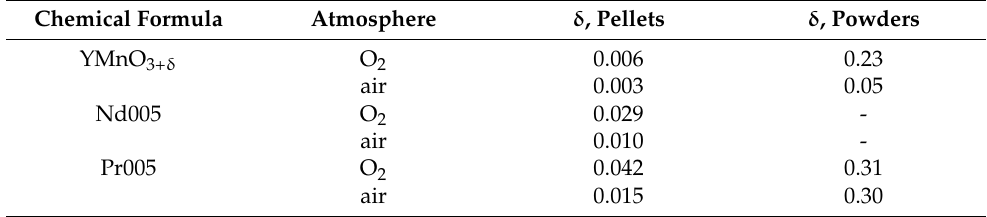
Table 2. Comparison of the oxygen excess δ at room temperature evaluated for the sintered pellets, with reference data for the fine powders [24]. Values given after cooling in air and in pure O 2 .